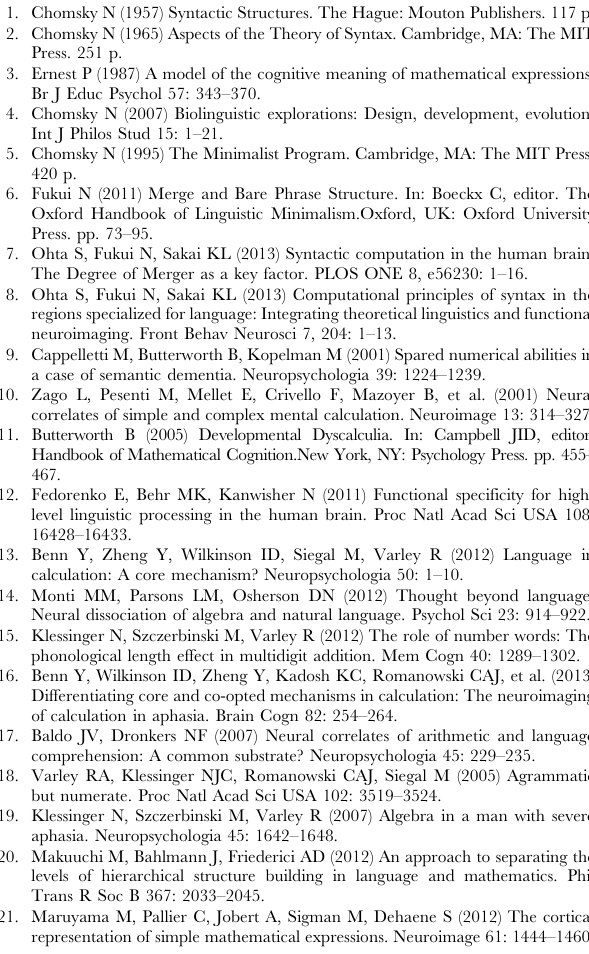
File S1 Table S1: Fittings and likelihood of various models tested in the L. SMG. Table S2: Fittings and likelihood of various models tested in the L. IPS. Table S3: Fittings and likelihood of various models tested in the R. IPS. Table S4: Fittings and likelihood of various models tested in the